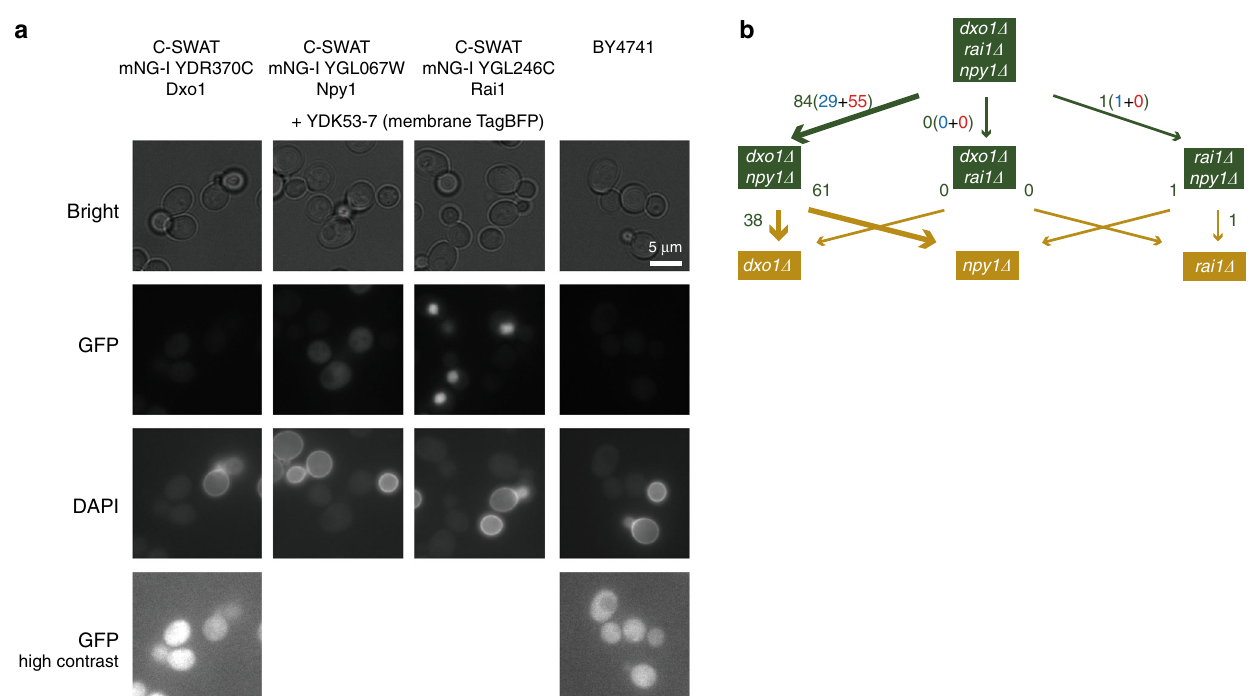
Fig. 9 Decapping enzyme localization and hierarchy. a Subcellular localization of Npy1, Dxo1, and Rai1. The proteins of interest were visualized as C-SWAT Neonl fusion proteins. The membrane marker protein TagBFP served as background control and was visualized in the DAPI channel. Due to the low intensity of the GFP signal for Dxo1, this image is shown again in high contrast, as is the BY4741 WT strain, exhibiting auto fl uorescence. Representative micrographs of three biologically independent replicates are shown, n = 3. b Analysis showing the number of RNA species that exhibit a TL shift upon reintroduction of the fi rst decapping enzyme (upper part, numbers next to the green arrows) into the dxo1 Δ rai1 Δ npy1 Δ deletion background, and the number of those disappearing entirely or showing reduced enrichment upon introduction of the second enzyme (lower part, numbers next to yellow arrows. TL shifting is de fi ned by TLI>0.1 or< − 0.1 and FDR<0.1. Blue and red numbers represent TL shifting to the proximal and distal side, respectively. For example, the route from the dxo1 Δ rai1 Δ npy1 Δ triple knockout to the dxo1 Δ npy1 Δ double knockout (i.e., introduction of Rai1) identi fi es 84 RNA species with shifted TLs, 38 of which disappear or show reduced enrichment upon additional introduction of Npy1 (tracing the path from the dxo1 Δ npy1 Δ to the dxo1 Δ mutant). Source data are provided as a Source Data fi